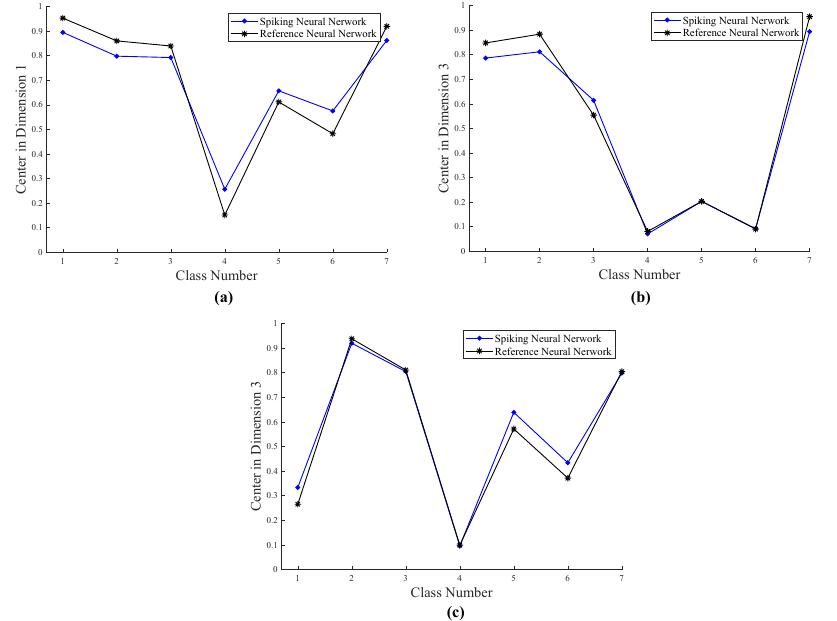
Figure 14. Values of Centers. ( a ) Value of Centers in Dimension 1. ( b ) Value of Centers in Dimension 2. ( c ) Value of Centers in Dimension